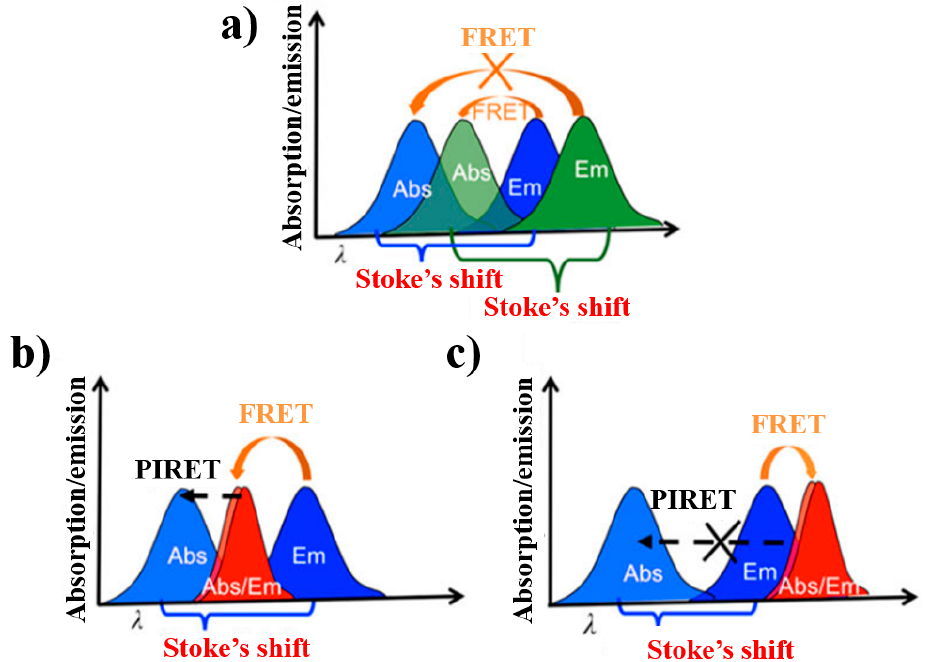
Figure 24. Schematic diagrams of energy transfer under di ff erent conditions in the NP–molecule hybrid state [99].